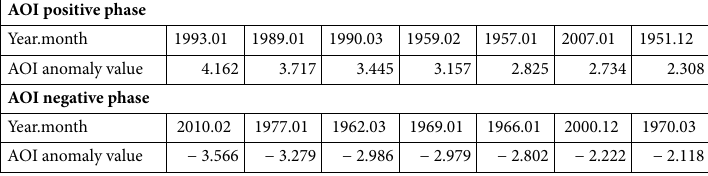
Table 1. The top six maximum and minimum months of the AOI from 1900 to 2015.